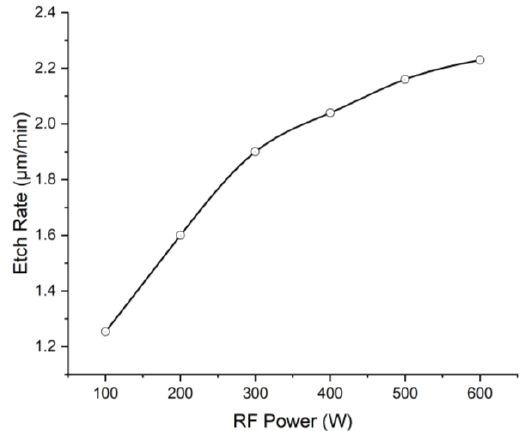
Figure 5. The relationship between etch rate and RF power under 2000 W ICP power, 10% CHF 3 gas composition, and 100 sccm etch gas flow speed.